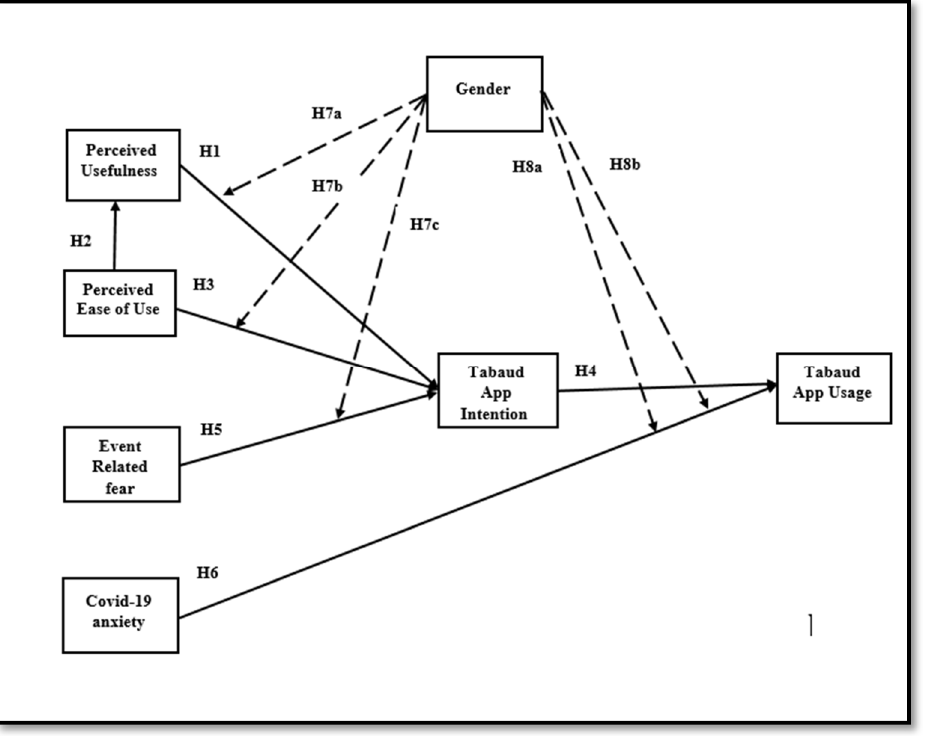
Figure 1. The research framework.